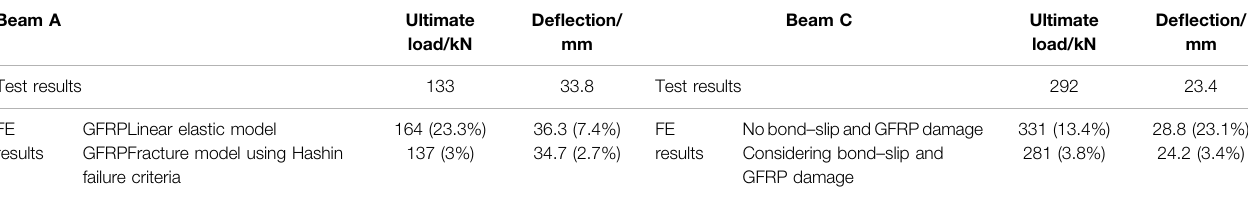
TABLE 2 | Comparison of FE results with experimental